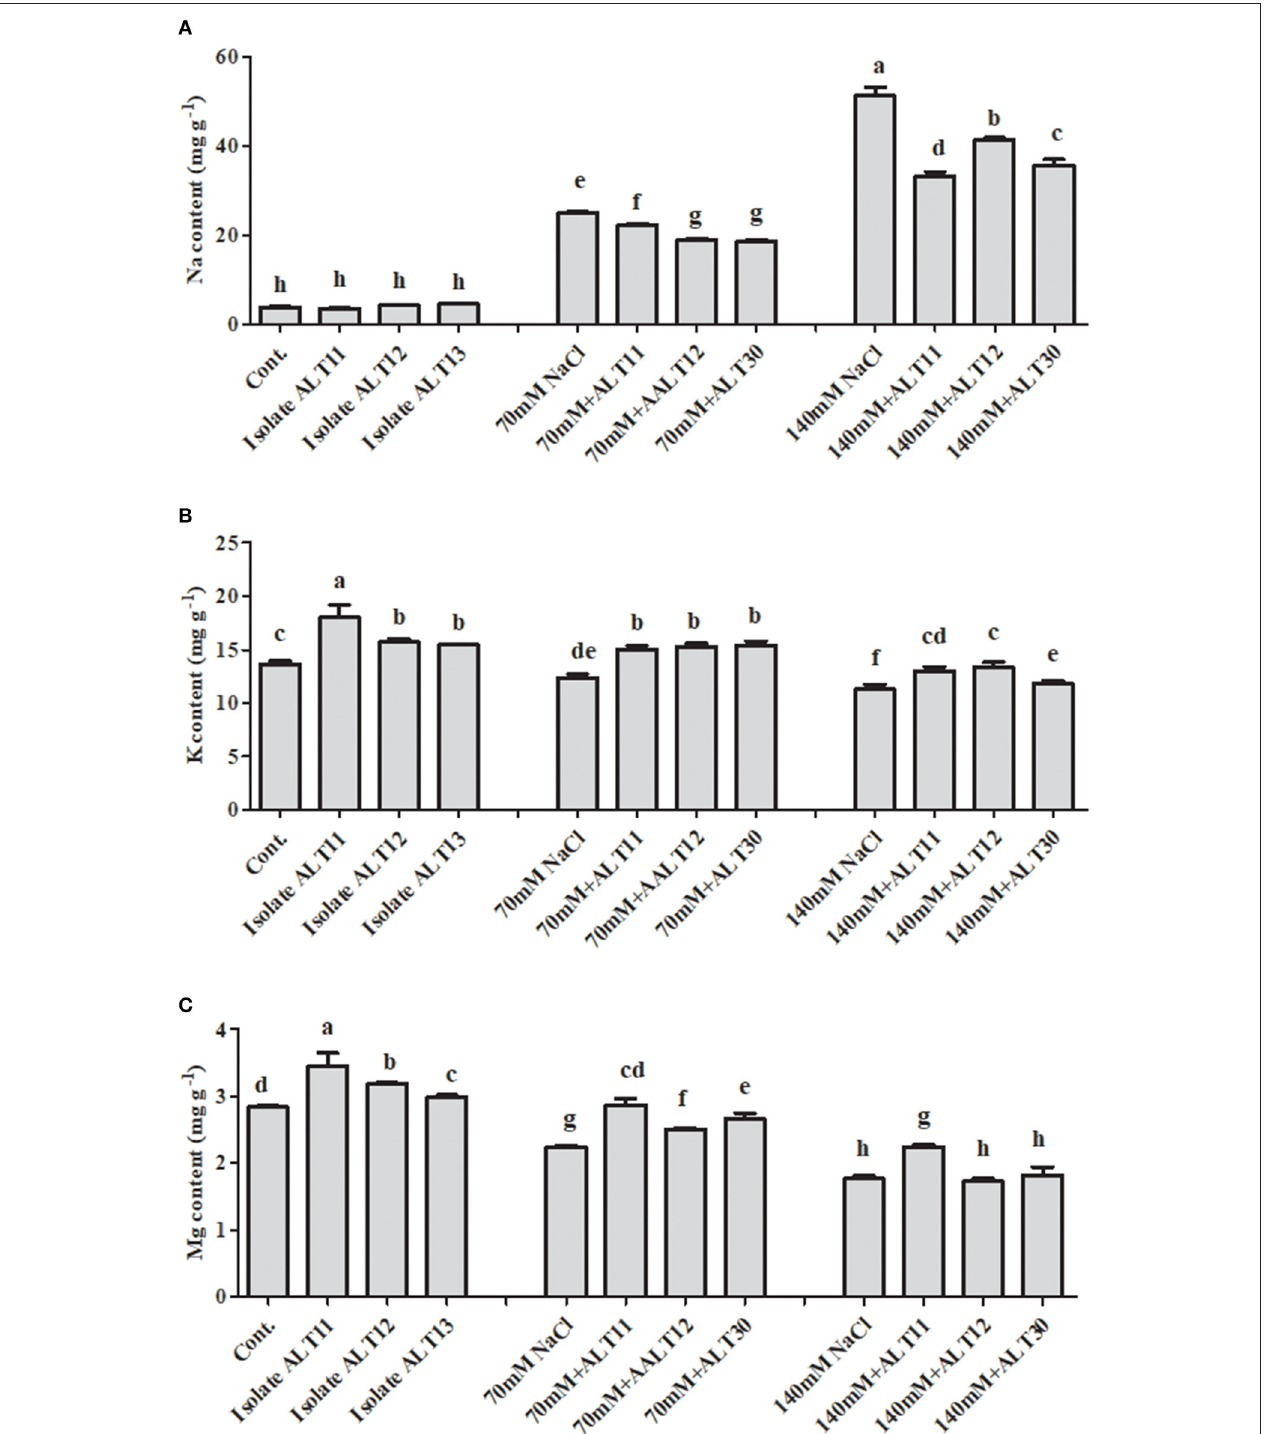
FIGURE 6 | The effect of isolates ALT11, ALT12, and ALT30 on sodium (Na + ), potassium (K + ) and magnesium (Mg) contents under normal conditions and NaCl stress (70 and 140mM). (A) Na + content, (B) K + content, and (C) Mg content in rice plants under normal conditions and NaCl stress. Different letters indicate significant differences between the mean values of three replicates ± standard